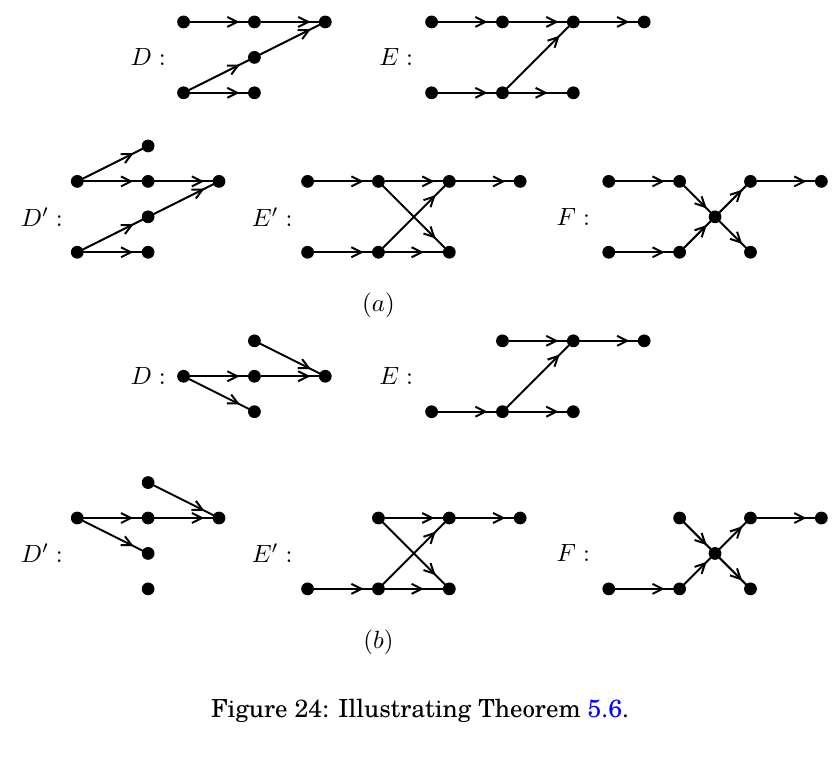
Figure 24: Illustrating Theorem 5.6.